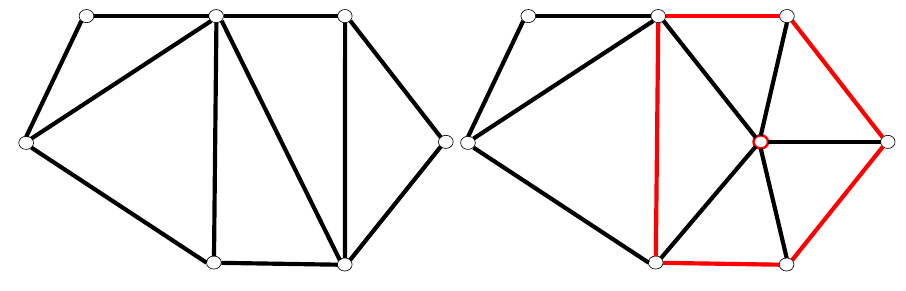
Figure 12. Insert a point in Delaunay Triangulation Network.